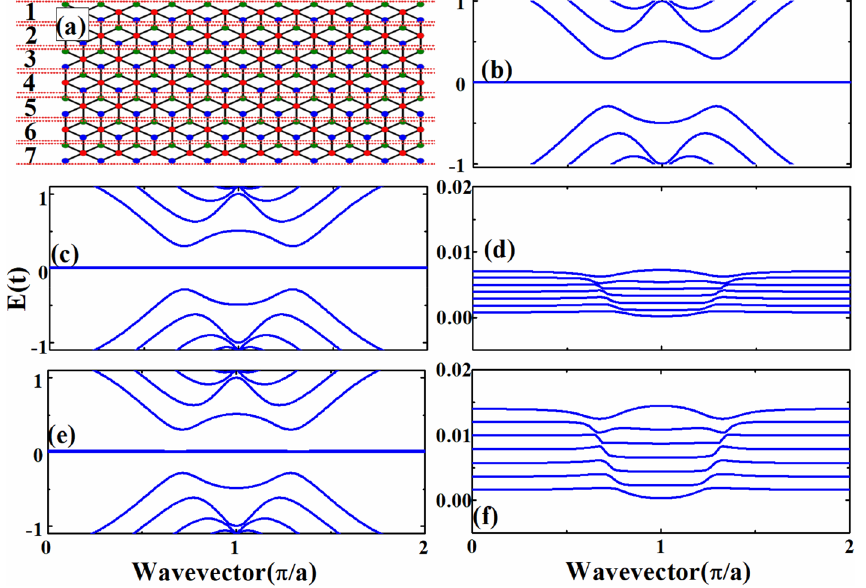
Figure 6. The changes in the flat band of a narrow zigzag α -T 3 lattice nanoribbon with a weaker and a stronger transverse electric field. ( a ) A narrow zigzag α -T 3 lattice nanoribbon. ( b ) Band structure of the narrow α -T 3 lattice ribbon with eE y = 0 . ( c ) Band structure of the narrow α -T 3 lattice ribbon with eE y = 0.005 t /nm . ( d ) The enlargement of a part of the flat band of ( c ). ( e ) Band structure of the narrow α -T 3 lattice ribbon with eE y = 0.01 t /nm . ( f ) The enlargement of a part of the flat band of ( e